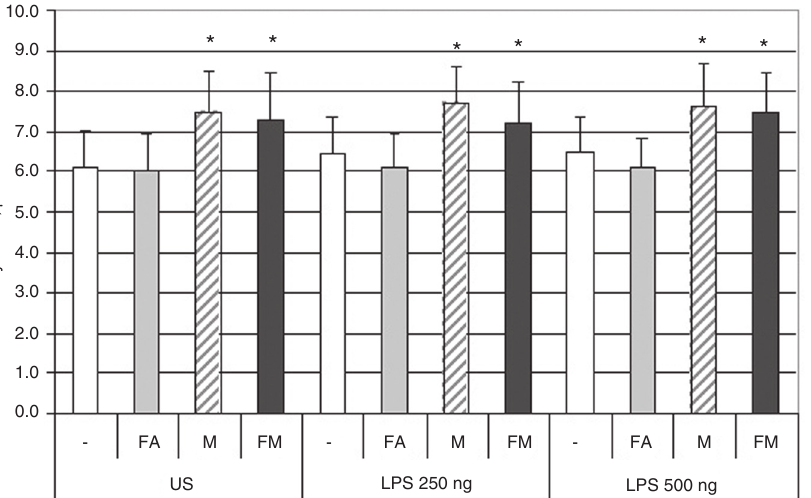
Figure 1 Homocysteine concentrations determined in unstimulated (US) and stimulated (LPS = lipopolysaccharide) monocytic cells (U-937) that were supplemented with folic acid (FA), methionine (M) and the combination of both compounds (FM). Significant differences are indi- cated by an asterisk (*p < 0.01).